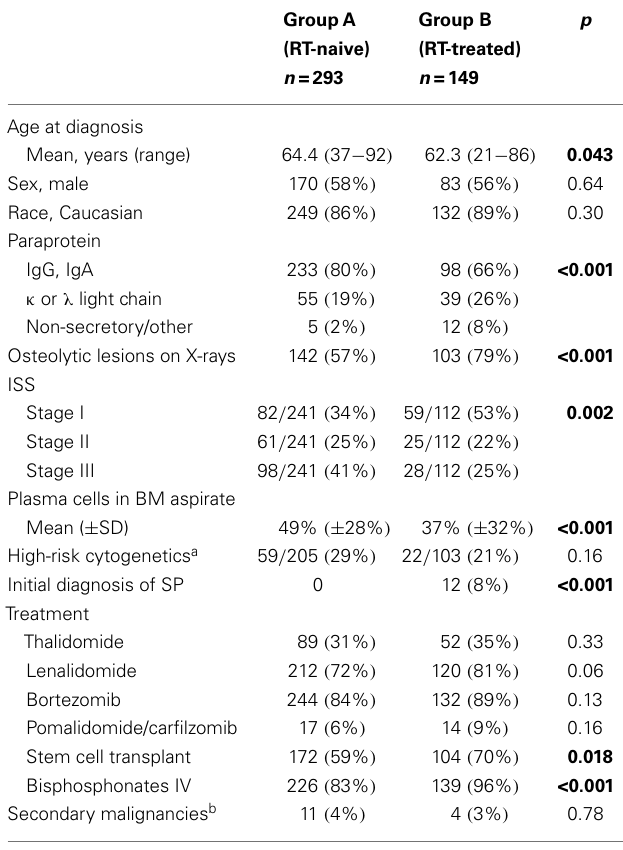
Table 1 | Characteristics of 442 consecutive patients with multiple myeloma (MM), divided in two groups, depending on whether or not they received radiation therapy